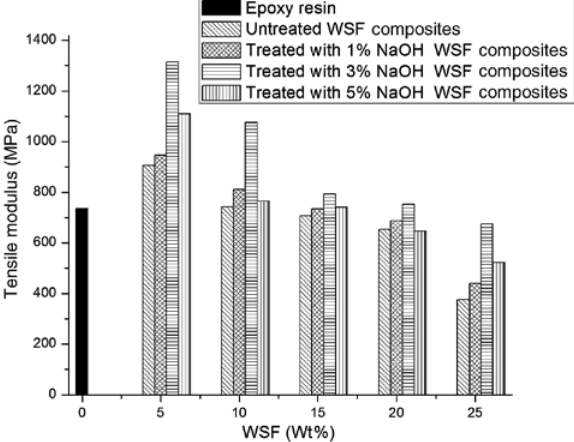
Figure 3: Effect of fiber content and alkali treatment on the flexural strength of WSF-epoxy composites.